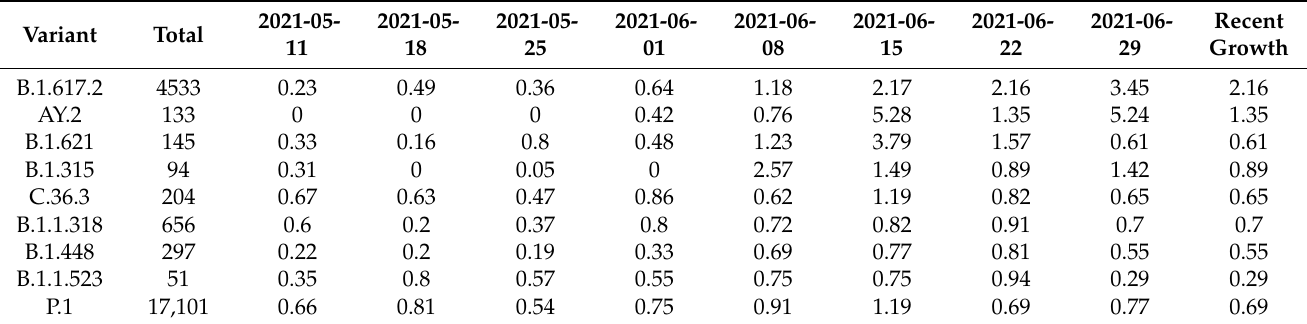
Table 1. Sample variants of COVID-19 (SARS-CoV2), cited from [103]. The dates of the variants are provided in the titles